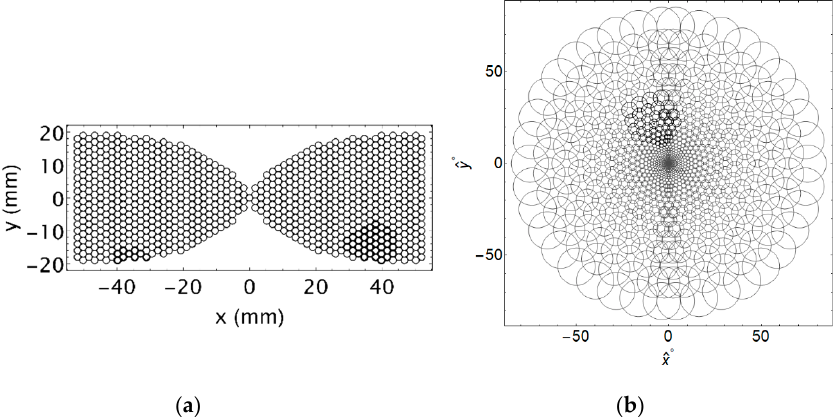
Figure 1. An idealized V1 geometry consisting of 939 columns in which negative values of x are used for the left hemisphere is shown in panel ( a ) and a corresponding idealized visual geometry consisting of 939 visual regions in which negative values of ˆ x ◦ denote the left visual field is shown in ( b ). The darker columns and corresponding regions are employed in computer simulations. This figure was constructed in the same fashion as Figure 2 in [35,36] but identifies 49 rather than 25 columns and corresponding visual regions that are included in simulations.